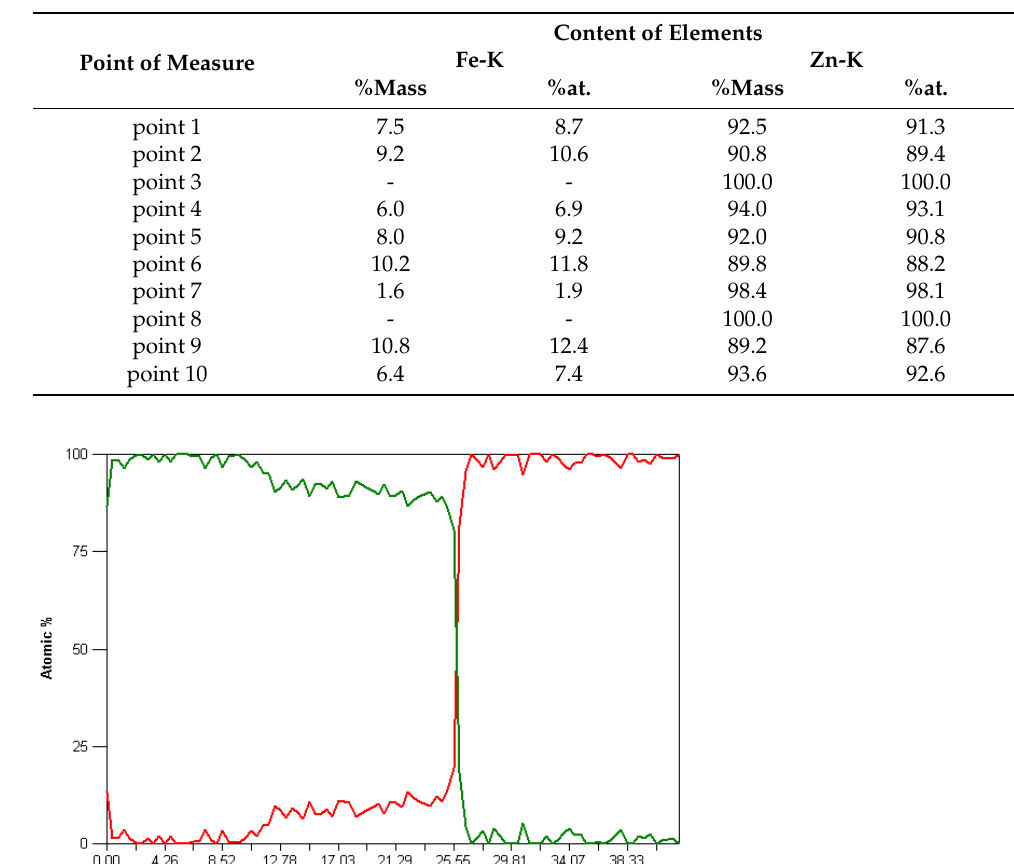
Table 4. Chemical composition of the selected micro-areas of the coating obtained on the wire in the K20 and H20 variant.